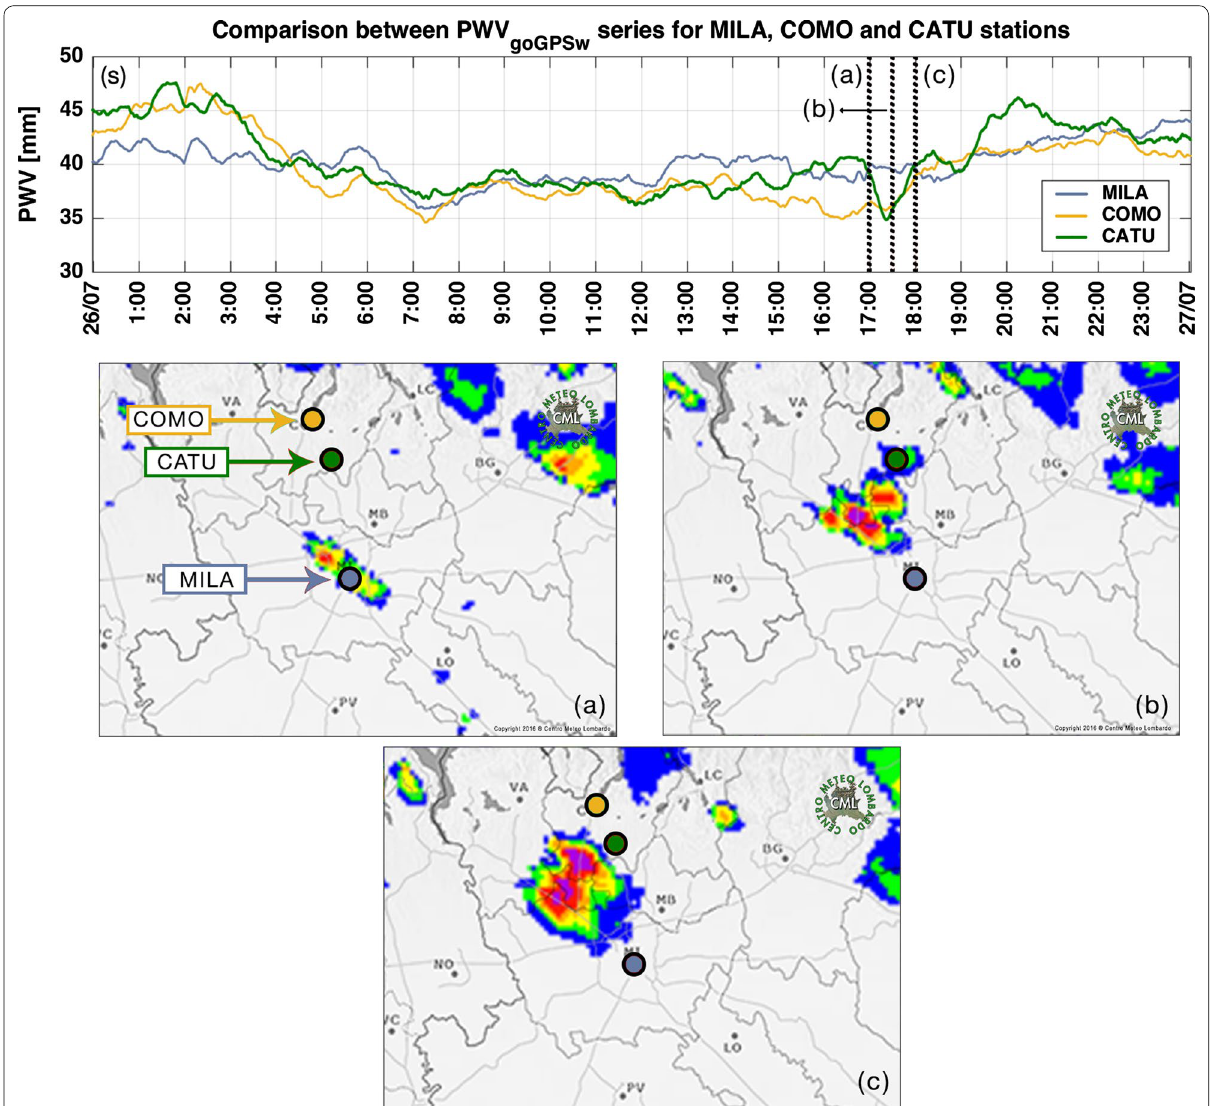
Fig. 11 July 26, 2016, event PWV goGPSw values of the stations affected by the rain event: MILA, CATU, and COMO